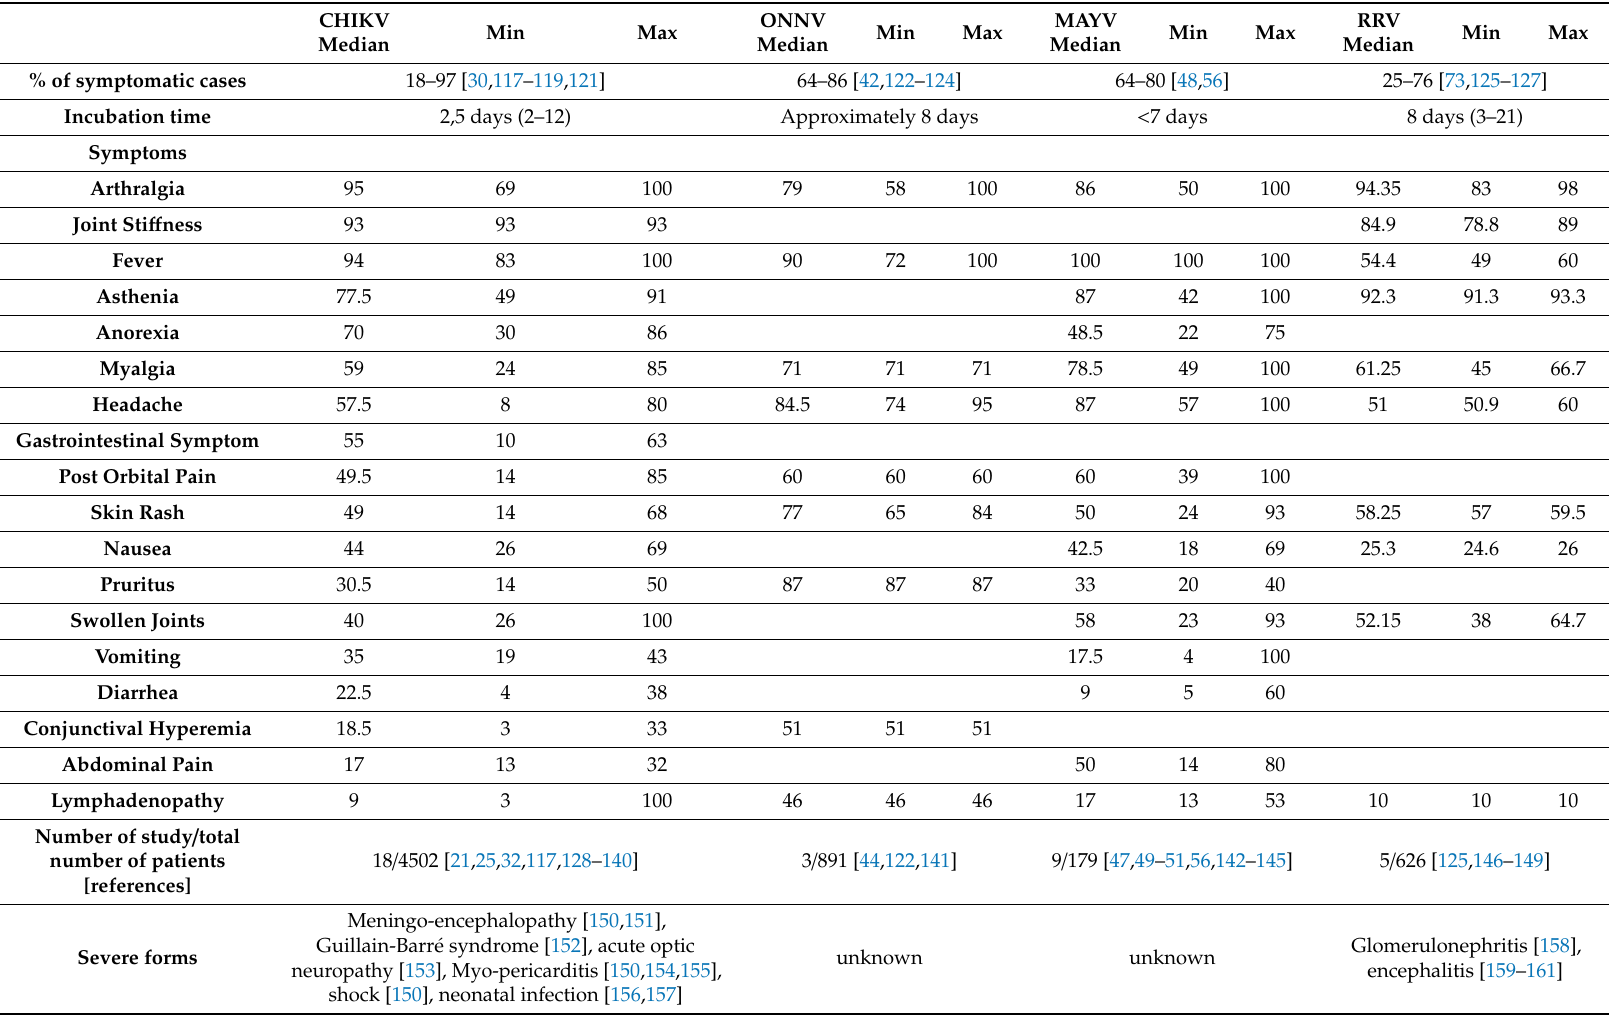
Table 2. Arthritogenic alphavirus acute infection symptoms, range of frequency reported in the listed